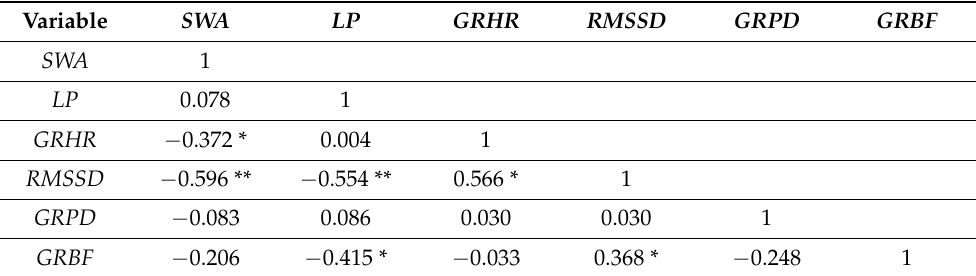
Table 2. Pearson correlation coefficient of OW indicators.